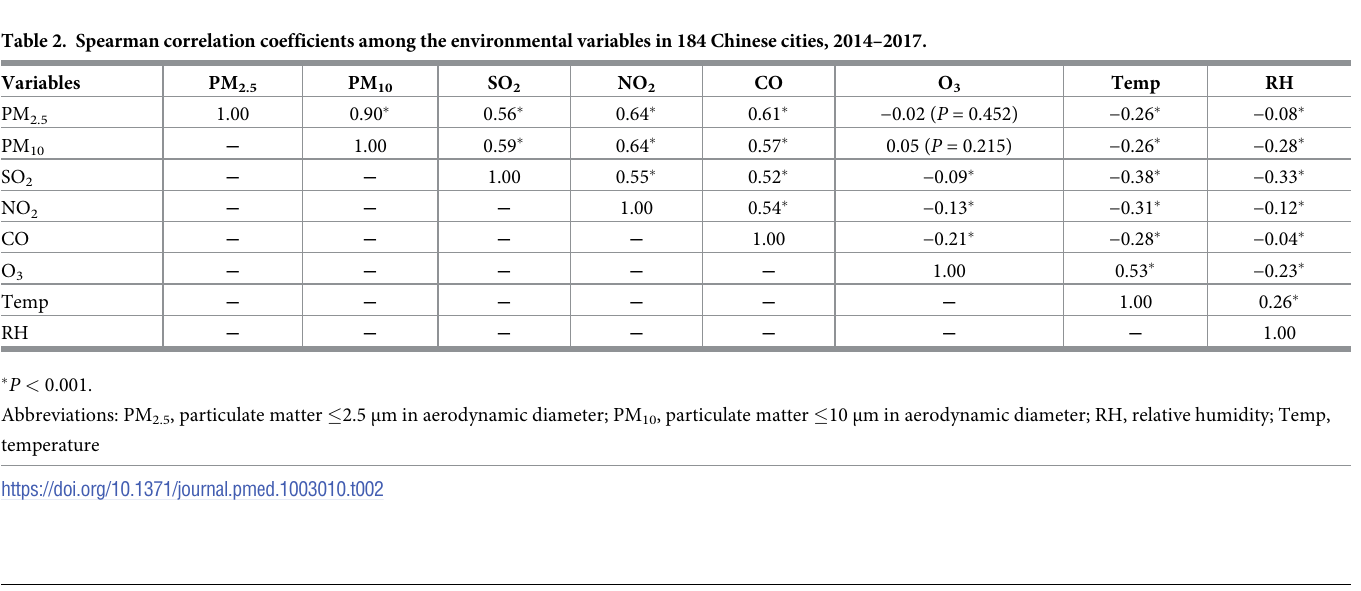
Table 4 presents the results of stratified analyses. The estimates were similar in males